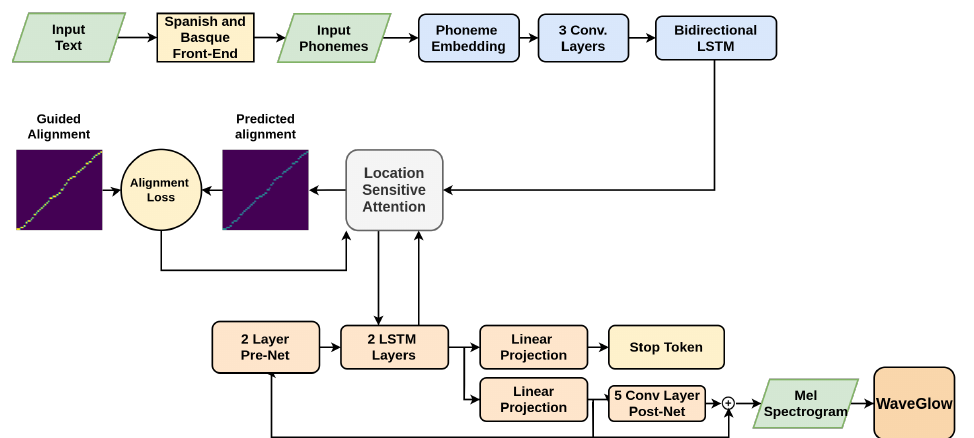
Figure 3. Architecture of the system trained using phonemes and pre-alignment guided